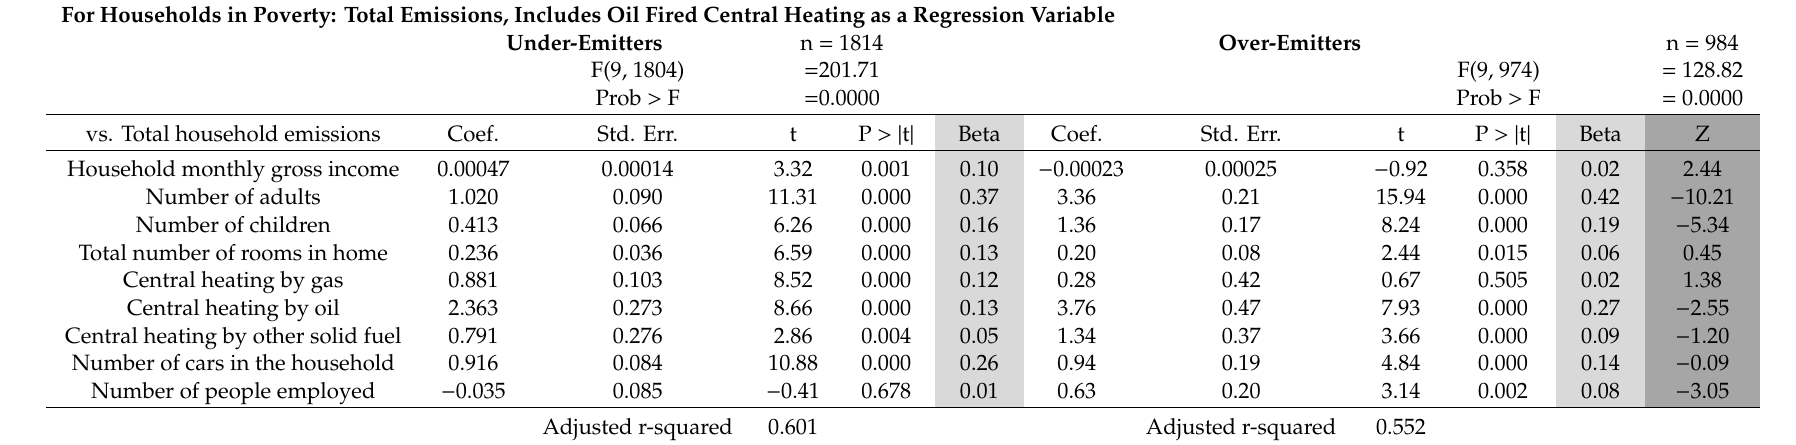
Table 3. Simple regression model of total household emissions by under- and over-emitters: those in poverty only. For Households in Poverty: Total Emissions, Includes Oil Fired Central Heating as a Regression Variable